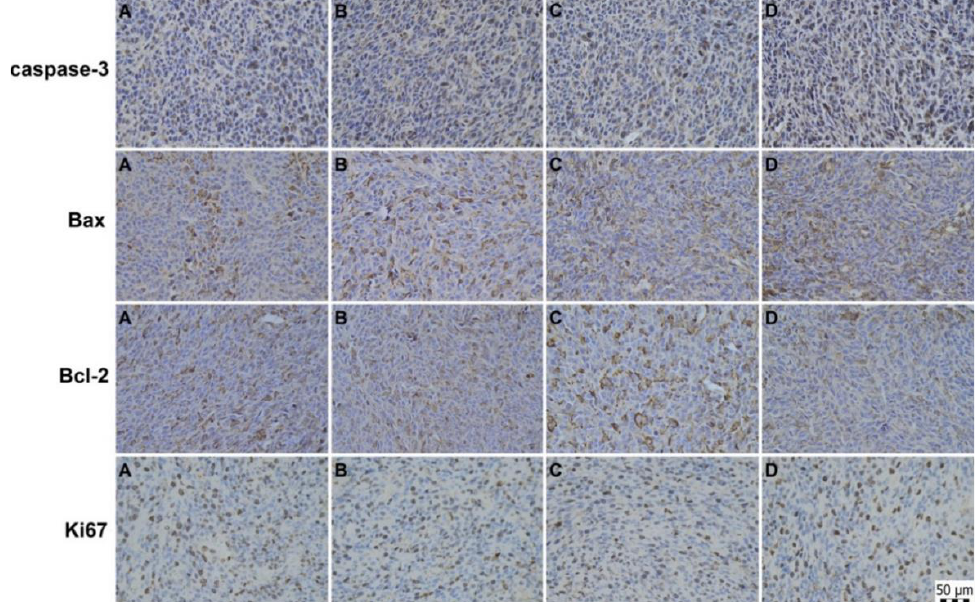
Figure 4. Representative images of caspase-3, Bax, Bcl-2, and Ki67 protein expressions in CT26 mouse colon carcinoma cells in vivo after the treatment with IM, 5-FU, and combination IM + 5-FU. ( A ) CT26, ( B ) CT26 + IM, ( C ) CT26 + 5-FU, ( D ) CT26 + IM + 5-FU. Polyclonal caspase-3 antibody (Bioss, Woburn, MA, USA), polyclonal Bax and Bcl-2 antibodies (Santa Cruz Biotechnology, Paso Robles, CA, USA), and monoclonal Ki67 antibody (Dako, Glostrup, Denmark) were used. Final magnifications in all photos: ×400. Table 3. The immunohistochemical (IHC) evaluation of caspase-3 (cytoplasmic), Bax, Bcl-2, and Ki67 expressions and histopathological evaluation of mitotic activity index (MAI) in mouse CT26 colon carcinoma cells after the administration of IM, 5-FU, and combination of IM + 5-FU. CT26 CT26 + IM CT26 + 5-FU CT26 + IM + 5-FU Caspase-3 26.33 ± 0.90